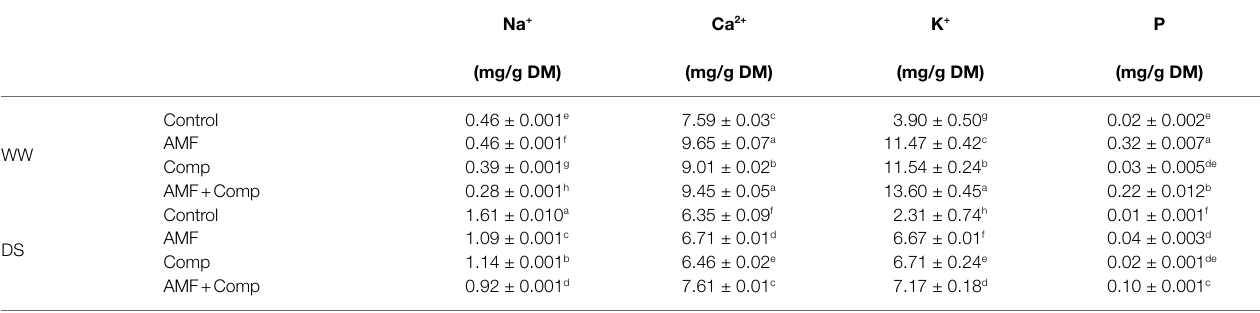
TABLE 3 | Seeds mineral composition of non-amended and non-inoculated quinoa (control) and quinoa inoculated with arbuscular mycorrhizal fungi (AMF) and/or amended with compost (Comp) subjected to different water regimes (WW; well-watered or DS: drought stress) after 4 months of cultivation. Na